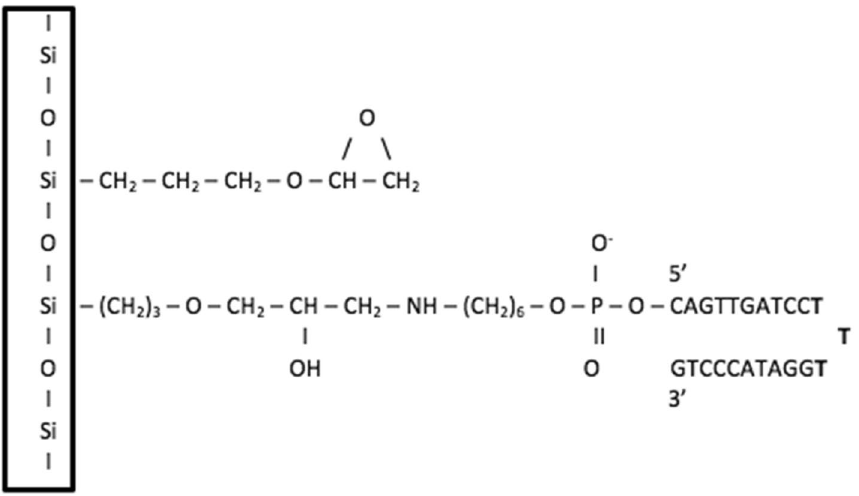
Figure 1. Cartoon of the chemical structure of epoxide-amine linker and epoxide monolayer attachment.(Top) Epoxide monolayer molecule attached to SiO 2 surface (Bottom) Epoxide-amine linker molecule attached to SiO 2 surface and 5 ′ terminal of the